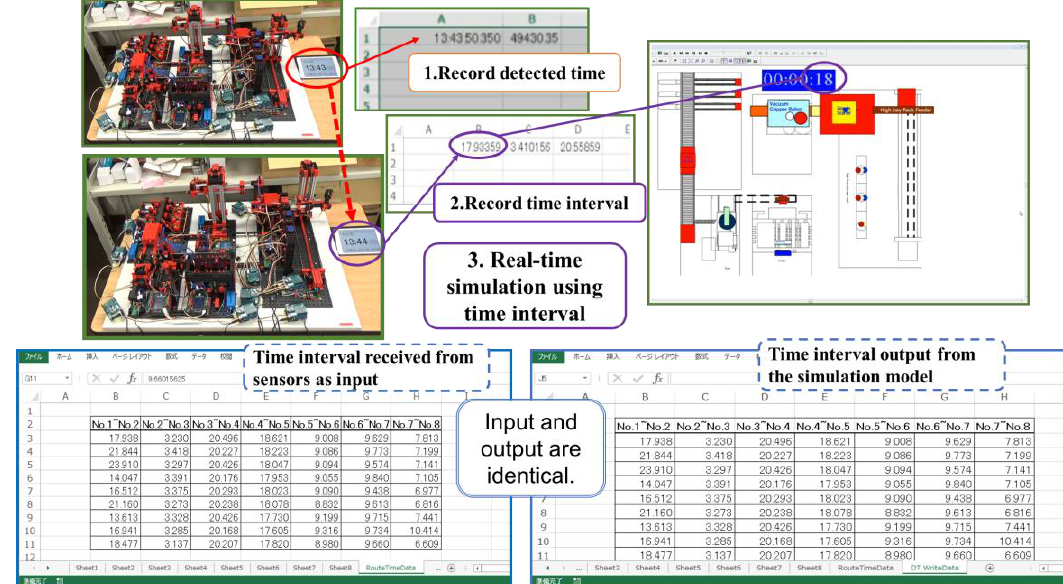
Figure 10. Synchronized display of input and output of interval time between physical and cyber sides.